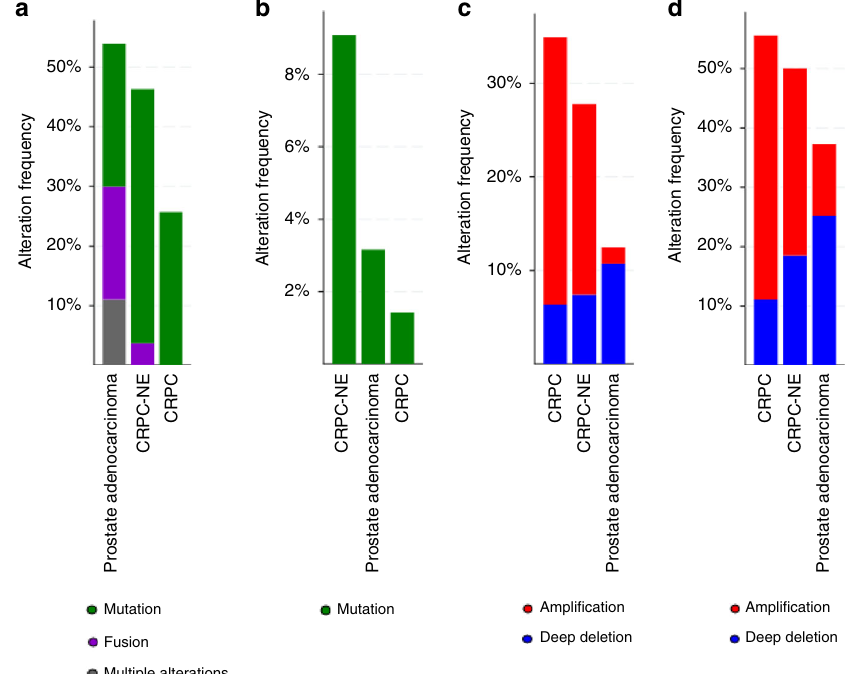
Fig. 7 Frequency of the CDX gene alterations in prostate cancer subtypes. The frequency of genes bearing trunk or branch alterations was examined in eight cBioPortal studies including CRPC and/or CRPC-NE tumor samples 7,64 – 70 . The eight interrogated studies gather 2604 tumor samples including 2029 adenocarcinoma, 70 CRPC, and 54 CRPC-NE. a , b Alteration frequency of genes bearing truncal ( a ) or acquired ( b ) SNVs and INDELs according to prostate cancer subtypes. c , d Alteration frequency of genes bearing truncal ( c ) or acquired ( d ) CNAs according to prostate cancer